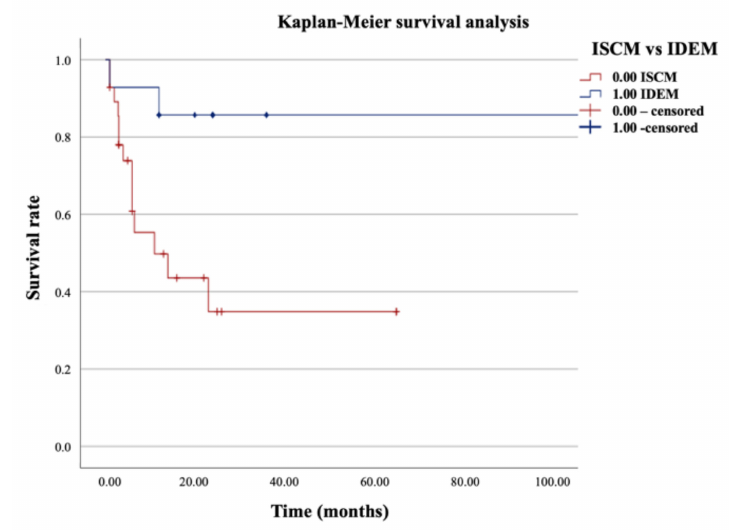
Figure 1. Kaplan-Meyer survival analysis between Intradural extramedullary (IDEM) and in- tramedullary (ISCMs) spinal metastases from